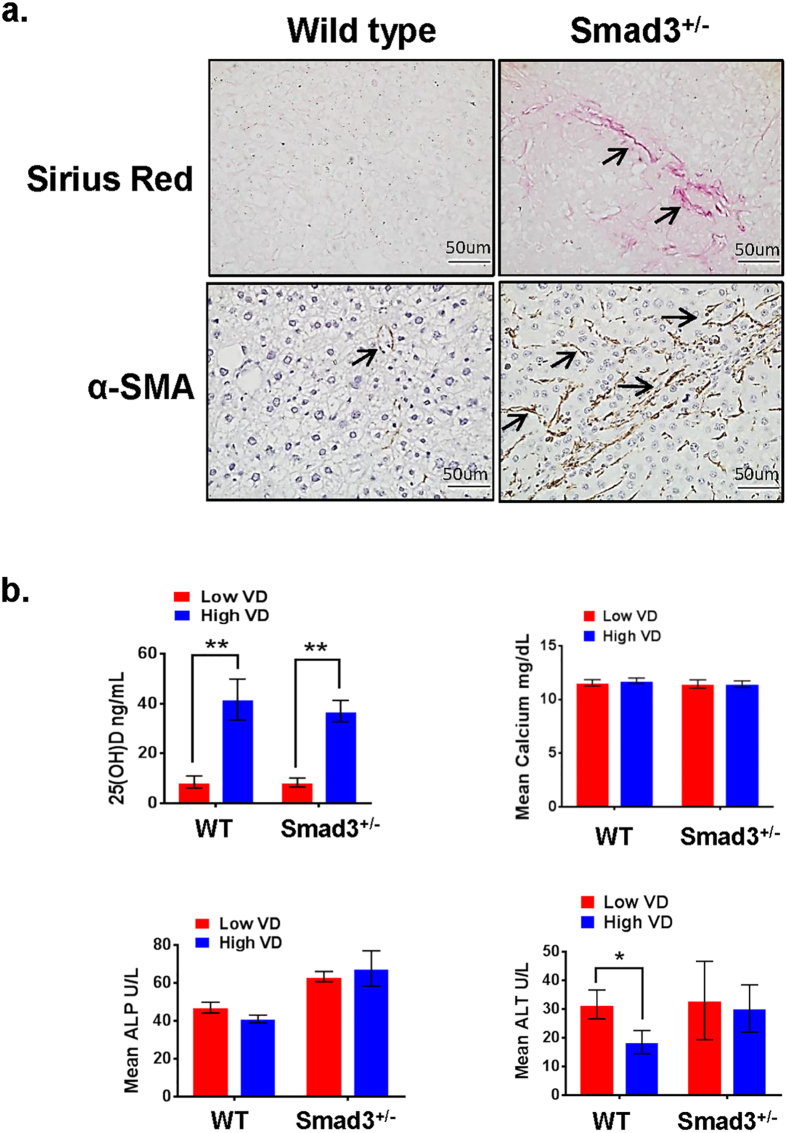
VD and Smad3 deficiency promote liver fibrosis.(a) Liver fibrosis in low VD treated wild type and Smad3+/− mice was analyzed by Sirius Red and α-smooth muscle actin (α-SMA) staining. Smad3+/− mice show higher levels of liver fibrosis. Arrows indicate fibrosis areas. (b) Serum VD, calcium, alanine transaminase (ALT) and alkaline phosphatase (ALP) concentrations were measured in blood from low/high VD treated wild type and Smad3+/− mice. The serum VD levels in the VD-deficient group were lower than 20 ng/ml (deficient) VD, while the high VD treated group had VD levels higher than 30 ng/ml (normal), without any difference in calcium levels. Liver functional enzymes ALT and ALP levels were in the normal range but the ALT and ALP levels were slightly higher in the mutants than the controls. Results are presented as mean ± SD. (*p < 0.05, **p < 0.01, Student’s t-test).